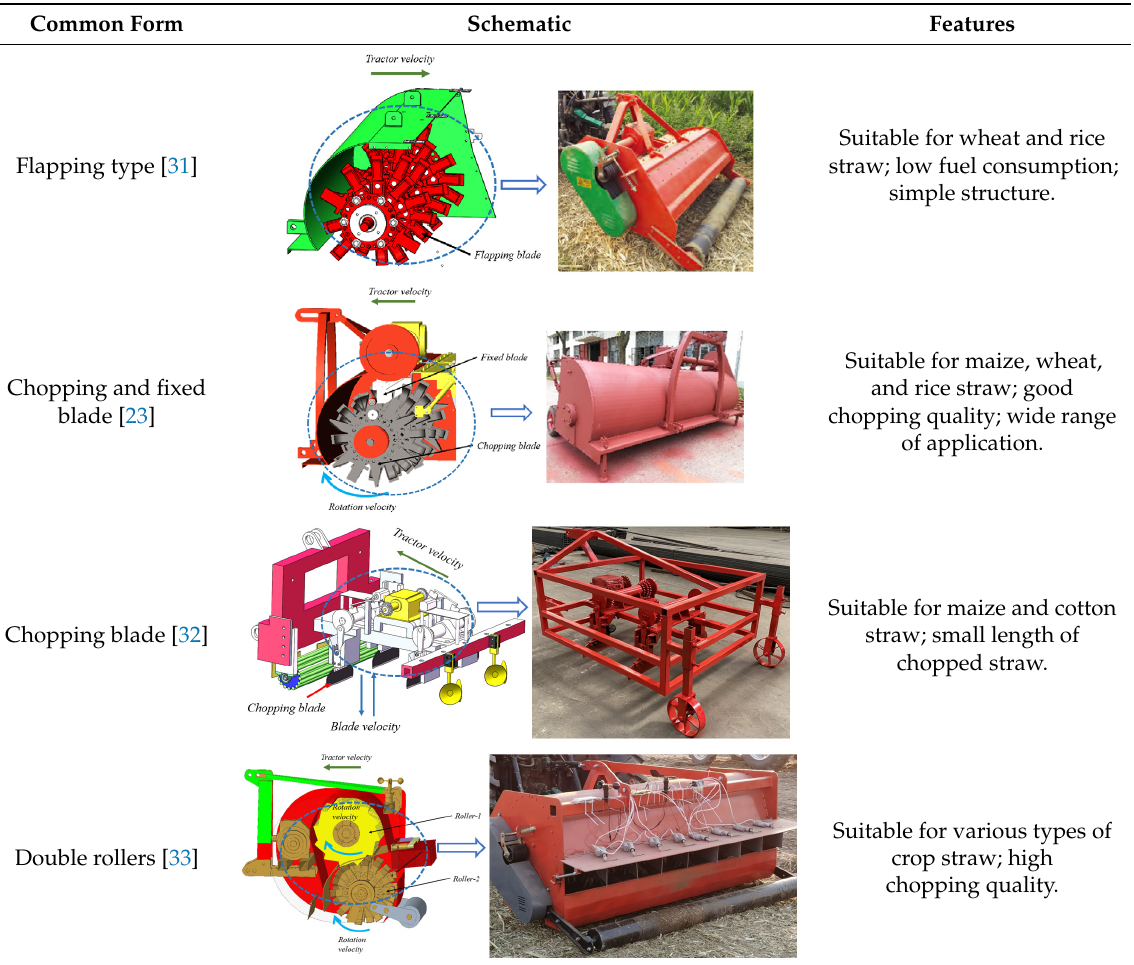
Table 4. Common forms of the chopper.